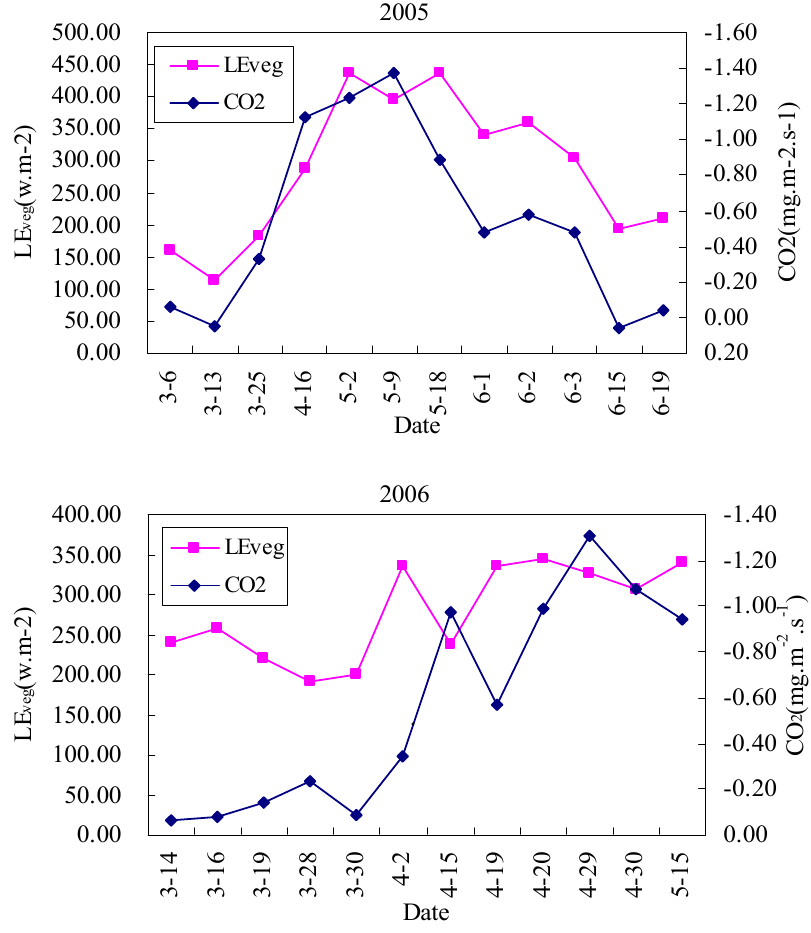
Figure 7 . Seasonal variation of the modeled λ E wheat growing period 2005 and 2006 (from March to